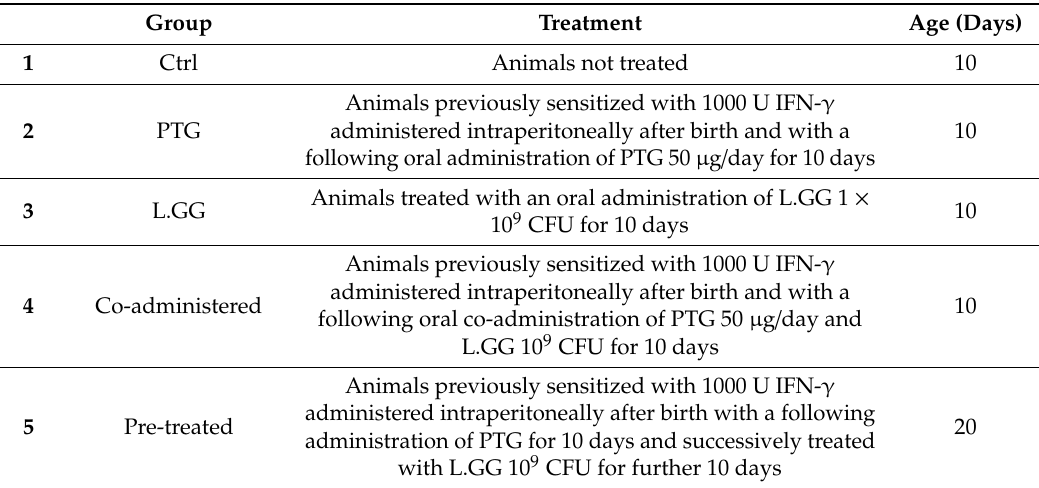
Table 1. Experimental